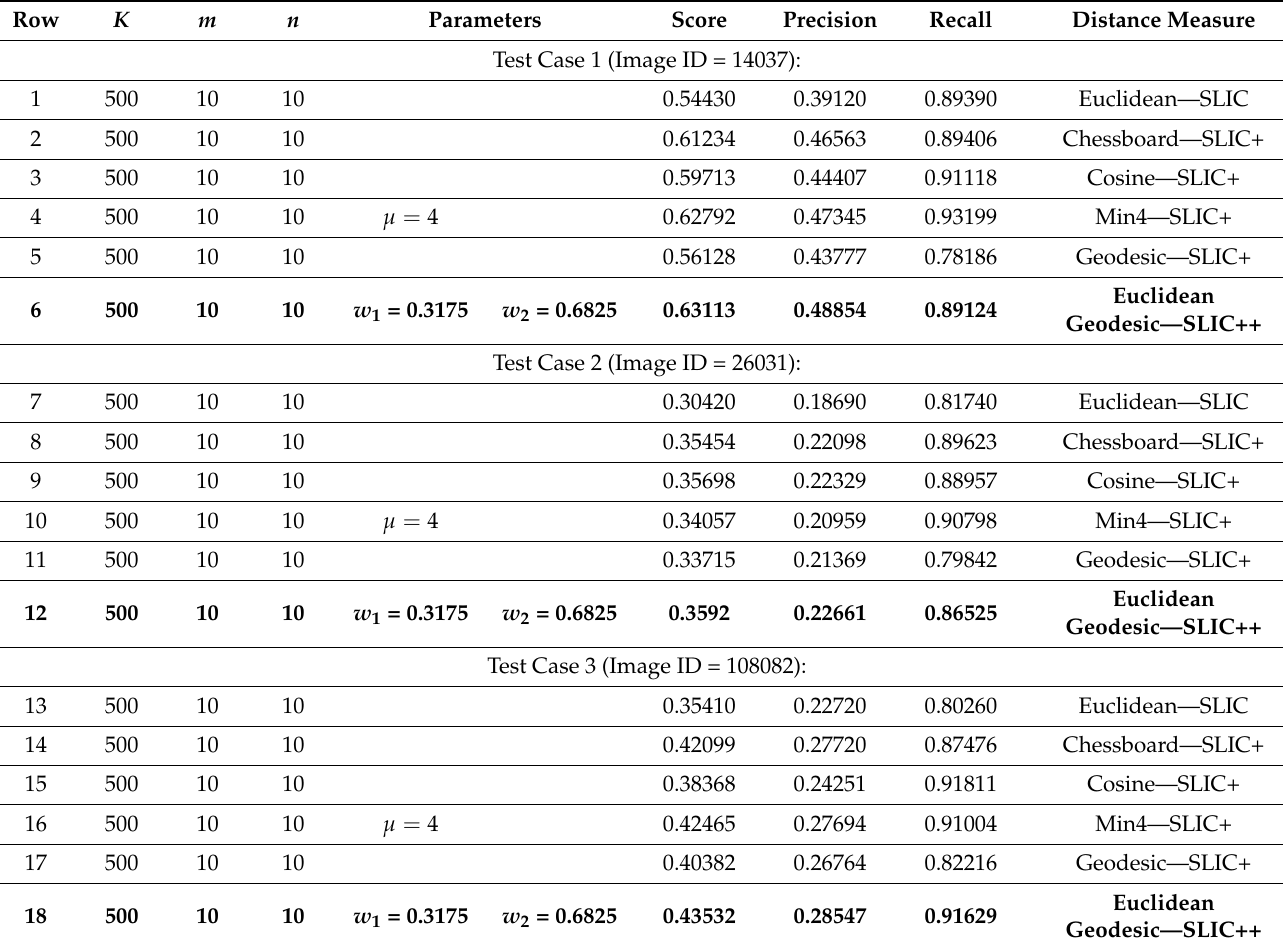
Table 3. Performance analysis of SLIC